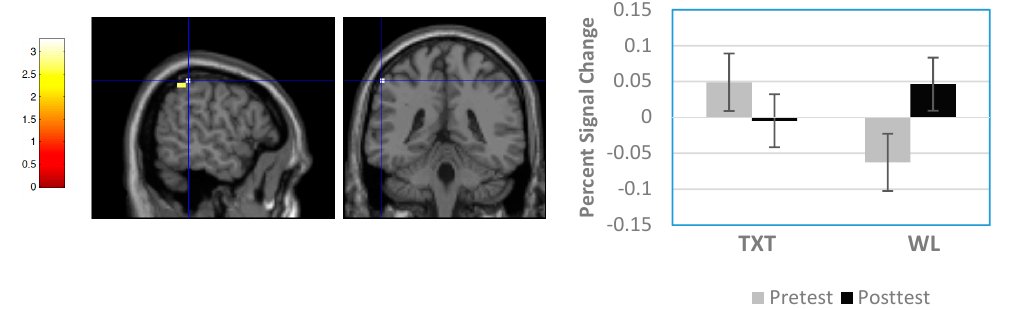
Figure 4. Sample Group × Time interaction result from whole-brain analysis. Panel on left shows sagittal and coronal views of significant cluster in left inferior parietal lobule (Brodmann Area (BA) 40; Montreal Neurological Institute (MNI) coordinates = − 56 − 40 52). Panel on right shows percent signal change differences between groups. Note signal decreased between pre-test and post-test in TXT and increased in WL.